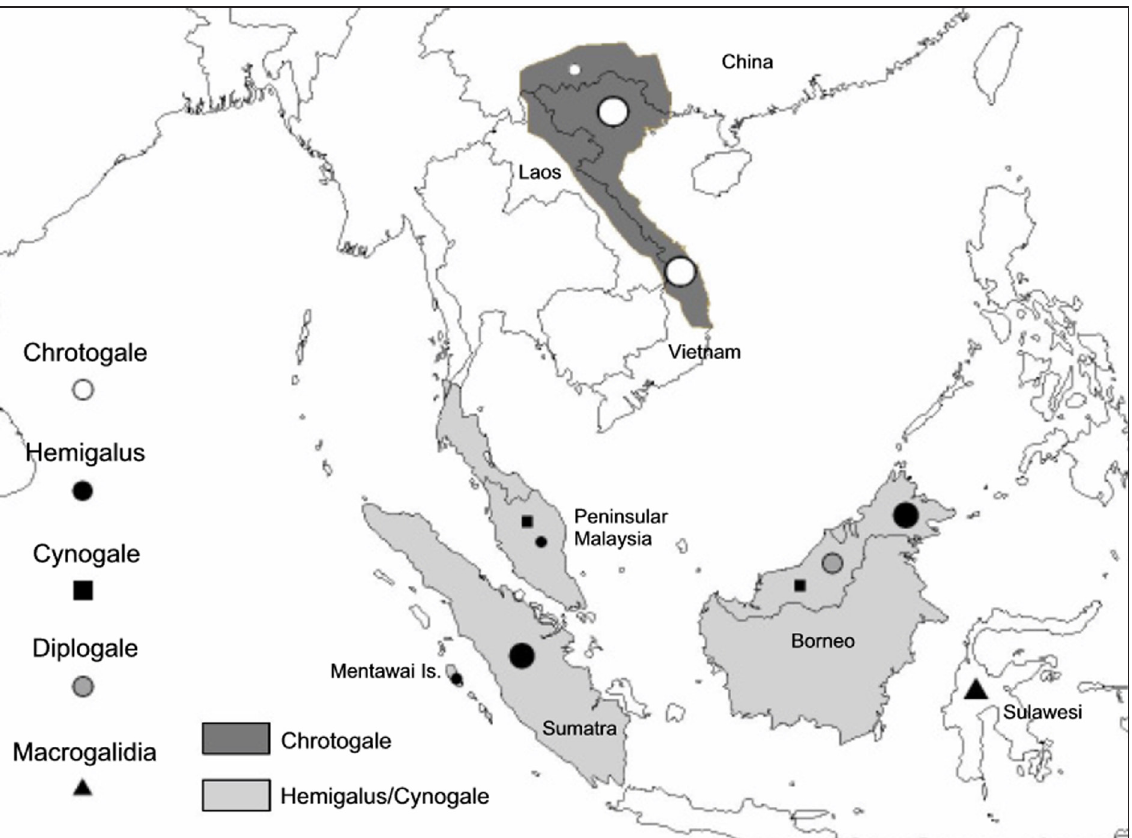
Fig. 1. Map showing the distribution of the samples of Hemigalinae used in this study. The gray shadings show the range of Chrotogale owstoni Thomas, 1912, Cynogale bennettii Gray, 1837 and Hemigalus derbyanus (Gray, 1837); Diplogale hosei (Thomas, 1892) is only found on Borneo and Macrogalidia musschenbroekii (Schlegel, 1879) only occurs on Sulawesi. The size of the sample symbols corresponds to the number of samples from each area (the smallest equals 1, and the largest equals